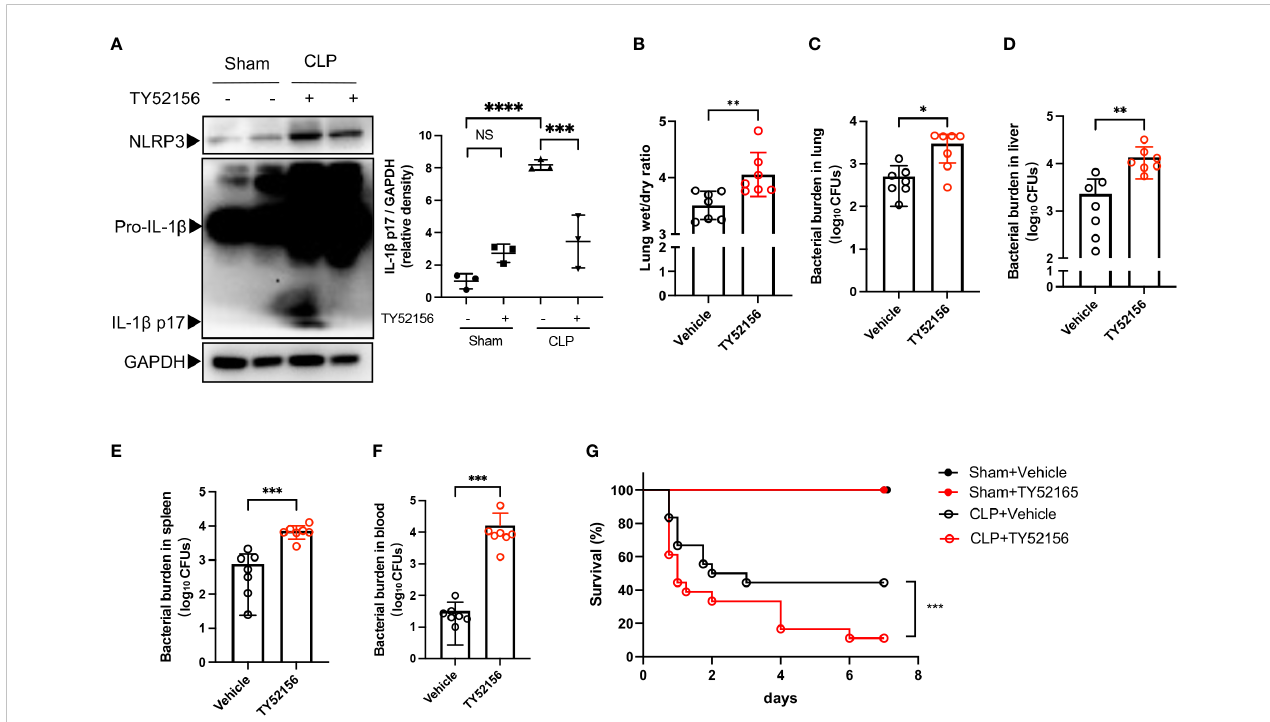
FIGURE 6 Inhibition of S1PR3 increases mortality and bacterial burden in sepsis. (A) Western blots of lung tissues from CLP mice treated with TY52156 or vehicle, and sham surgery control treated with TY52156 or vehicle (n=3 in each group) Values are presented as mean ± SD. ***p < 0.001, ****p < 0.0001, one-way ANOVA. (B) Lung wet/dry ratio of mice undergone CLP and then treated with TY52156 (10mg/kg) or vehicle (n=7 in each group). Values are presented as mean ± SD. **p < 0.01, two-tailed t-test. (C-F) Bacterial burden in the lung (C) , liver (D) , spleen (E) , and blood (F) of mice undergone CLP and then treated with TY52156 (10mg/kg) or vehicle (n=7 in each group). Values are presented as the mean of log10 CFU ± SD (C-F) . *p < 0.05, **p < 0.01, ***p < 0.001, Mann-Whitney test. (G) Kaplan Meier survival curves of mice undergone CLP or Sham surgery and then treated with TY52156 (10mg/kg) or vehicle (n=6 in Sham groups, n=18 in CLP groups). ***p < 0.001, log-rank test. NS,